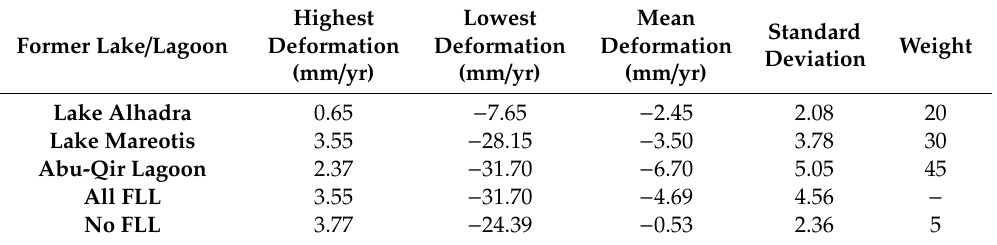
Table 3. Deformation in former lakes and lagoons dewatering (FLLD) areas of Alexandria.